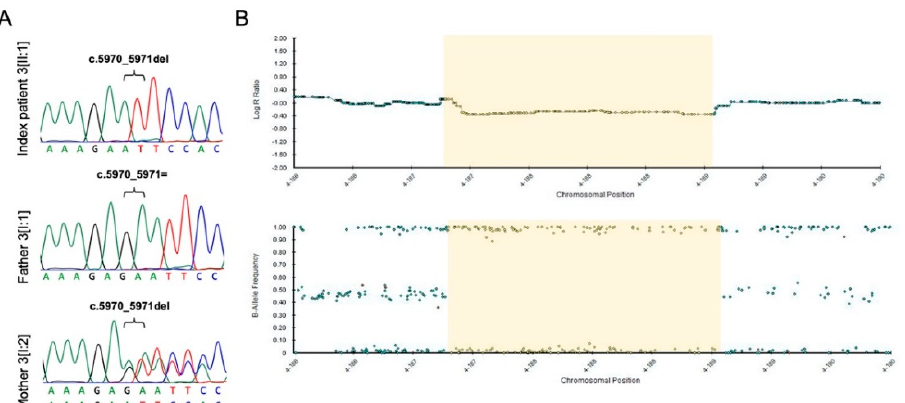
Figure 5. FAT1 frameshift variant and deletion in index patient 3[II:1] and both parents. ( A ) Sanger sequencing results of index patient 3[II:1] and both parents for the FAT1 frameshift variant. Index patient 3[II:1] and the mother (individual 3[I:2]) are hemizygous and heterozygous, respectively, for the FAT1 frameshift variant (c.5970_5971del; p.(Asn1991PhefsTer19)). ( B ) Single nucleotide polymorphism (SNP) microarray data (B-allele frequency and Log R ratio chart) of the 4q35.1–q35.2 region for SNP array analysis of index patient 3[II:1]. Index patient 3[II:1] and the father (individual 3[I:1]) are hemizygous for SNPs in the deleted region (B allele frequency chart) and show reduced signal intensity (Log R ratio chart). The maximal deleted region is 1.8 Mb (chr4:187,149,541–188,971,489), with the approximately deleted region indicated in